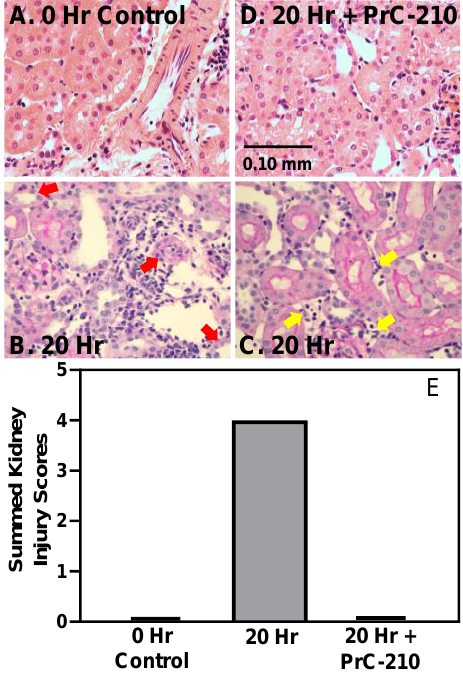
Figure 2. Histology of ( A ) BN kidney upon removal from BN rat. ( B – D ) BN kidneys 20 h following transplant into LEW rats. The “20 h” control kidneys ( B , C ) were flushed with room temperature UW Solution prior to transplant, and +PrC-210 kidneys ( D ) were flushed with room temperature UW Solution containing 30 mM PrC-210 prior to transplant, and recipient LEW rat also received three intraperitoneal systemic PrC-210 doses in the eight hours following transplant. Panel ( B ) red arrows highlight tubulitis pathology, and Panel C yellow arrows highlight peritubular capillaritis pathology. Panel ( E ) shows summed tubulitis and peritubular capillaritis severity scores for three kidneys in each of the indicated groups.